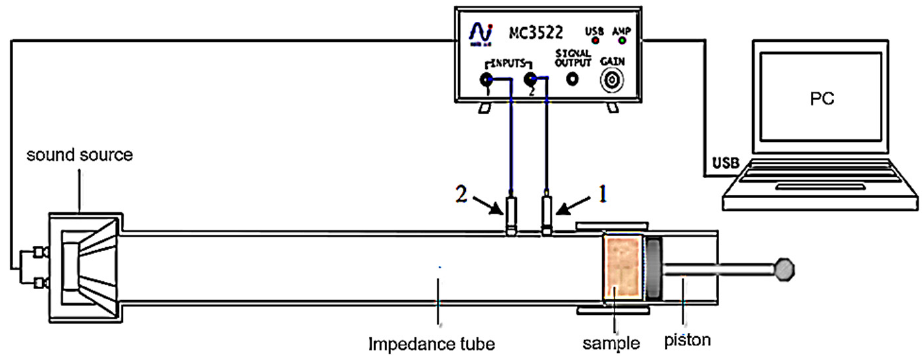
Figure 1. Schematic diagram of the sound-absorption test. Test environment setting: the temperature was 25 ◦ C, sound speed was 346.11 m/s, atmospheric pressure was 101.325 Pa, relative humidity was